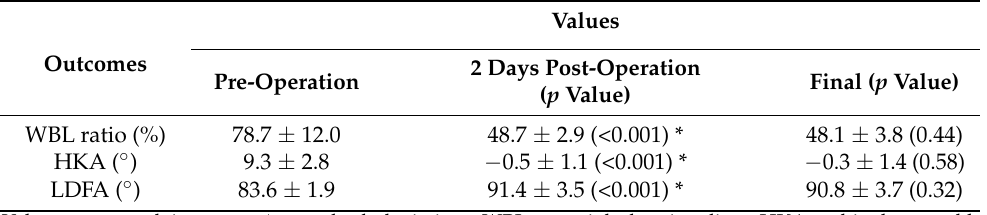
Table 4. Radiological results before and after operation.